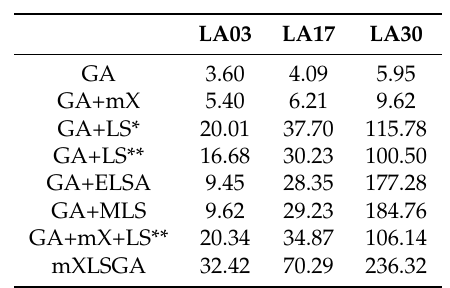
Table 3. Average time spent in seconds by each configuration of the proposed method to solve each instance of the Job Shop Scheduling Problem (JSSP) during 35 independent